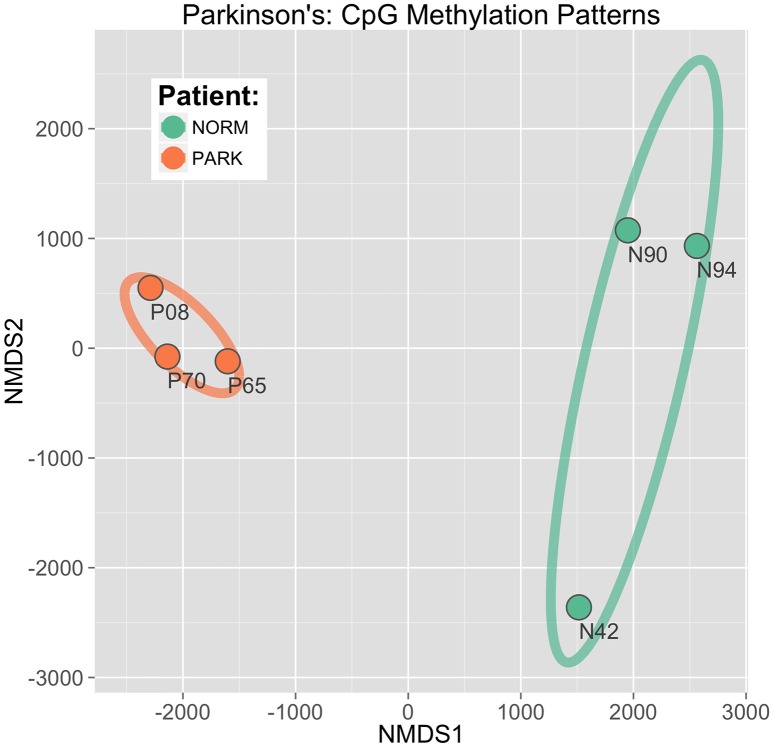
CpG discrimination of Parkinson's individuals from healthy individuals. Using an ordinate analysis technique of non-metric multidimensional scaling (NMDS), CpG methylation profiles were compared among individuals to isolate patterns conserved within groups while also differing between groups (Parkinson's patients vs. normal healthy males). The first two component axes are plotted to locate the individual sample points in a 2D plane. Ellipses drawn represent 95% Confidence Intervals around the location of the true group means.